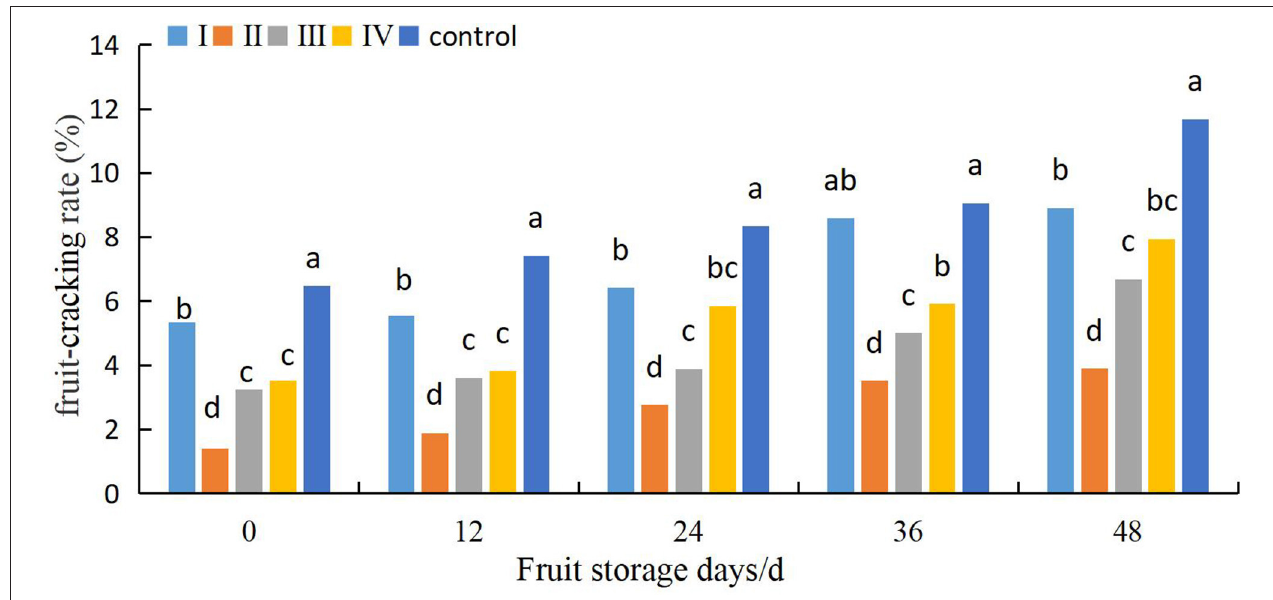
FIGURE 8 | Effects of pre-harvest calcium treatment on post-harvest cracking of grapes. Data are presented as mean ± standard. Lowercase letters represent significant differences ( P < 0.05).